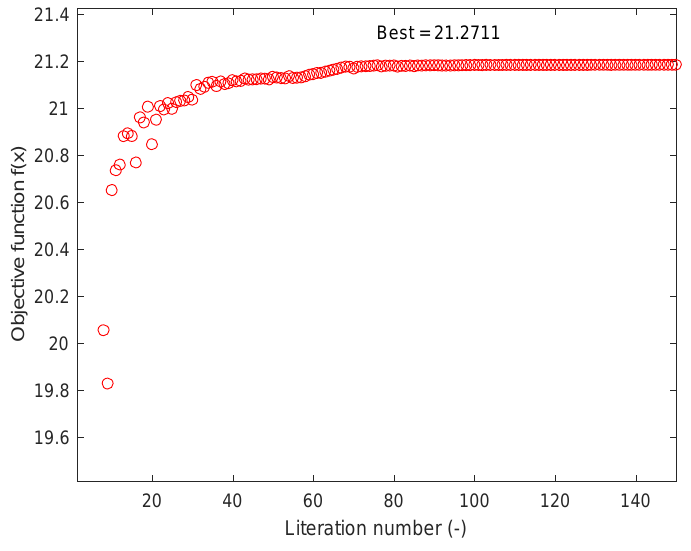
Figure 11. The iterative course for the optimization process considering rated power.